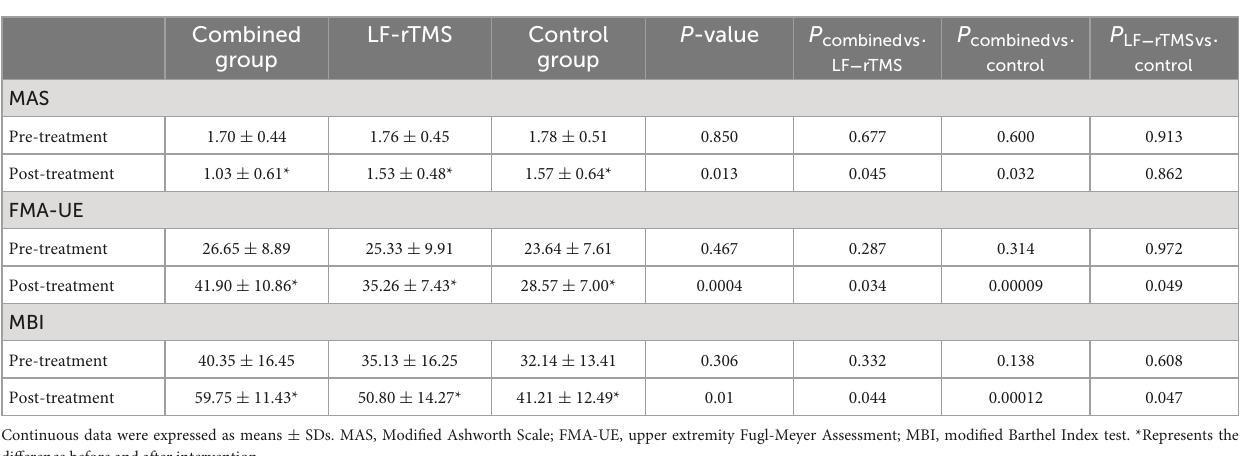
TABLE 2 Comparison of clinical characteristics among the combined group, LF-rTMS, and control group.